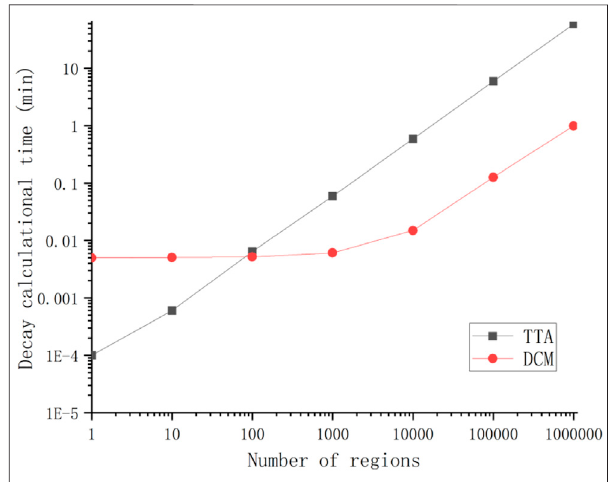
FIGURE 5 | Decay calculational times for various numbers of